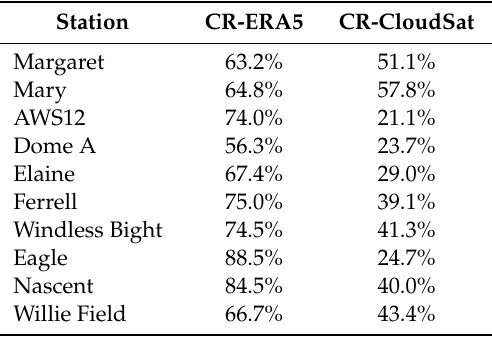
Table 5. Capture rate (CR) of ERA5 and CloudSat for ESEs and EAEs, respectively. CR-ERA5 shows the percentage of ERA5 that captured ESEs and CR-CloudSat shows the percentage of CloudSat that captured extreme snowfall events from ERA5